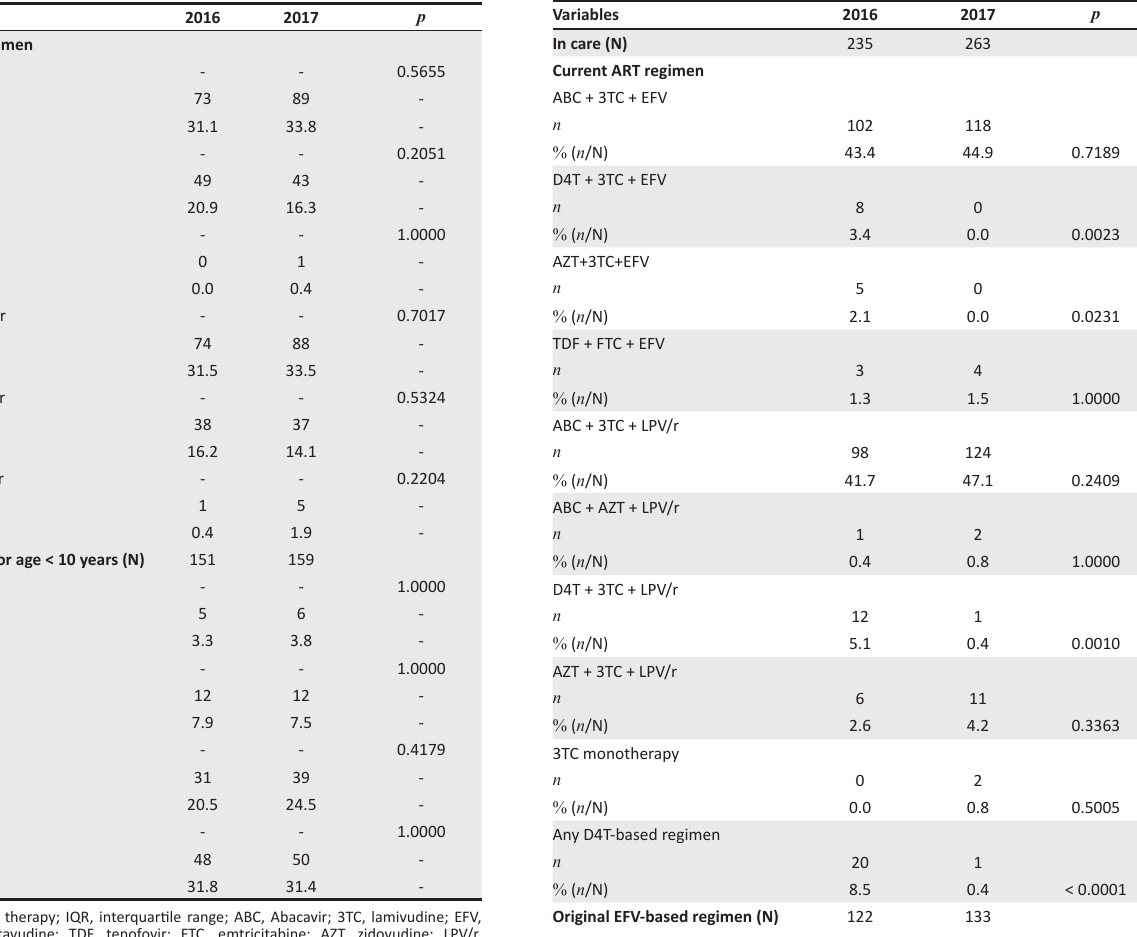
TABLE 1 (Continues...): Demographic data and baseline antiretroviral therapy data. TABLE 2: The details of current antiretroviral